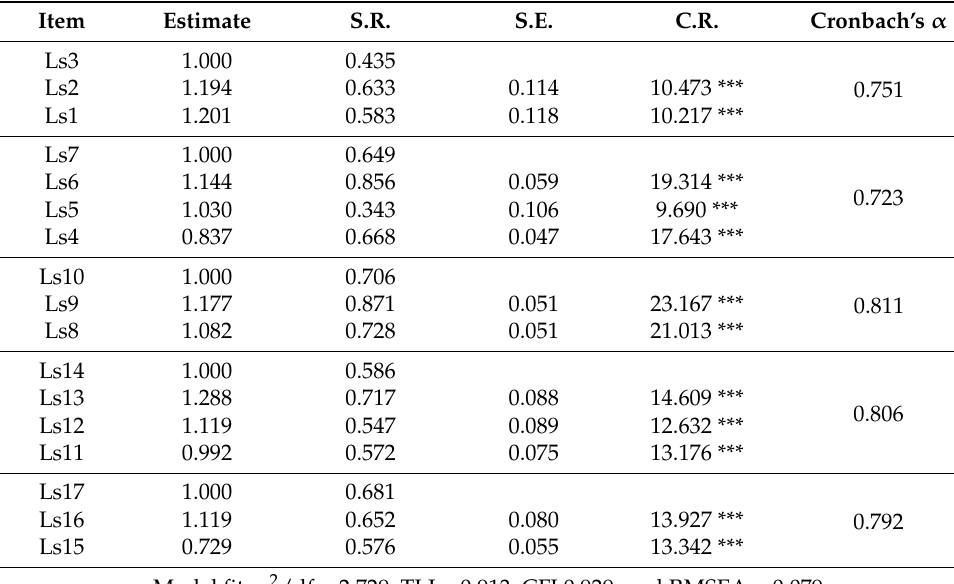
Table 2. Fit indices for confirmatory factor and reliability analysis. Item Estimate S.R. S.E.